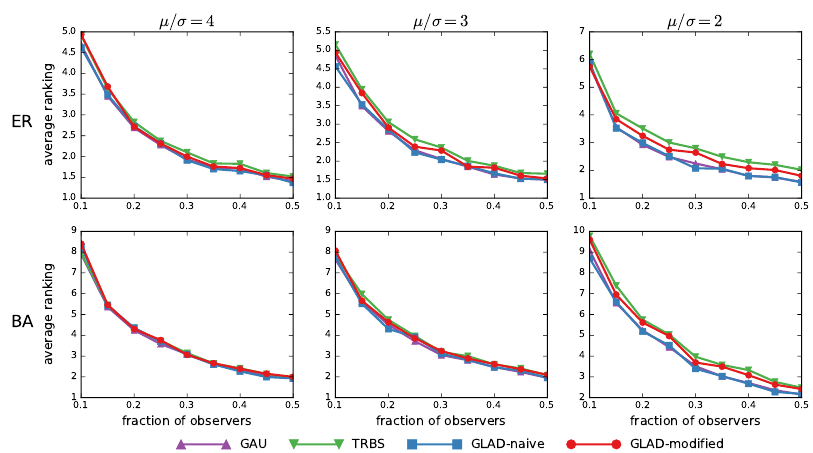
Figure 2. Average ranking of the real source in different source localization algorithms on synthetic trees. In each tree, the number of nodes is 100 and the diffusion delay along edges follows N ( µ , σ 2 ) . Only the mean delay µ is used to identify the source.